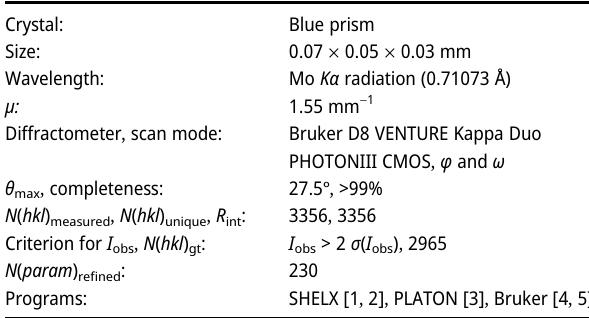
Table  : Data collection and